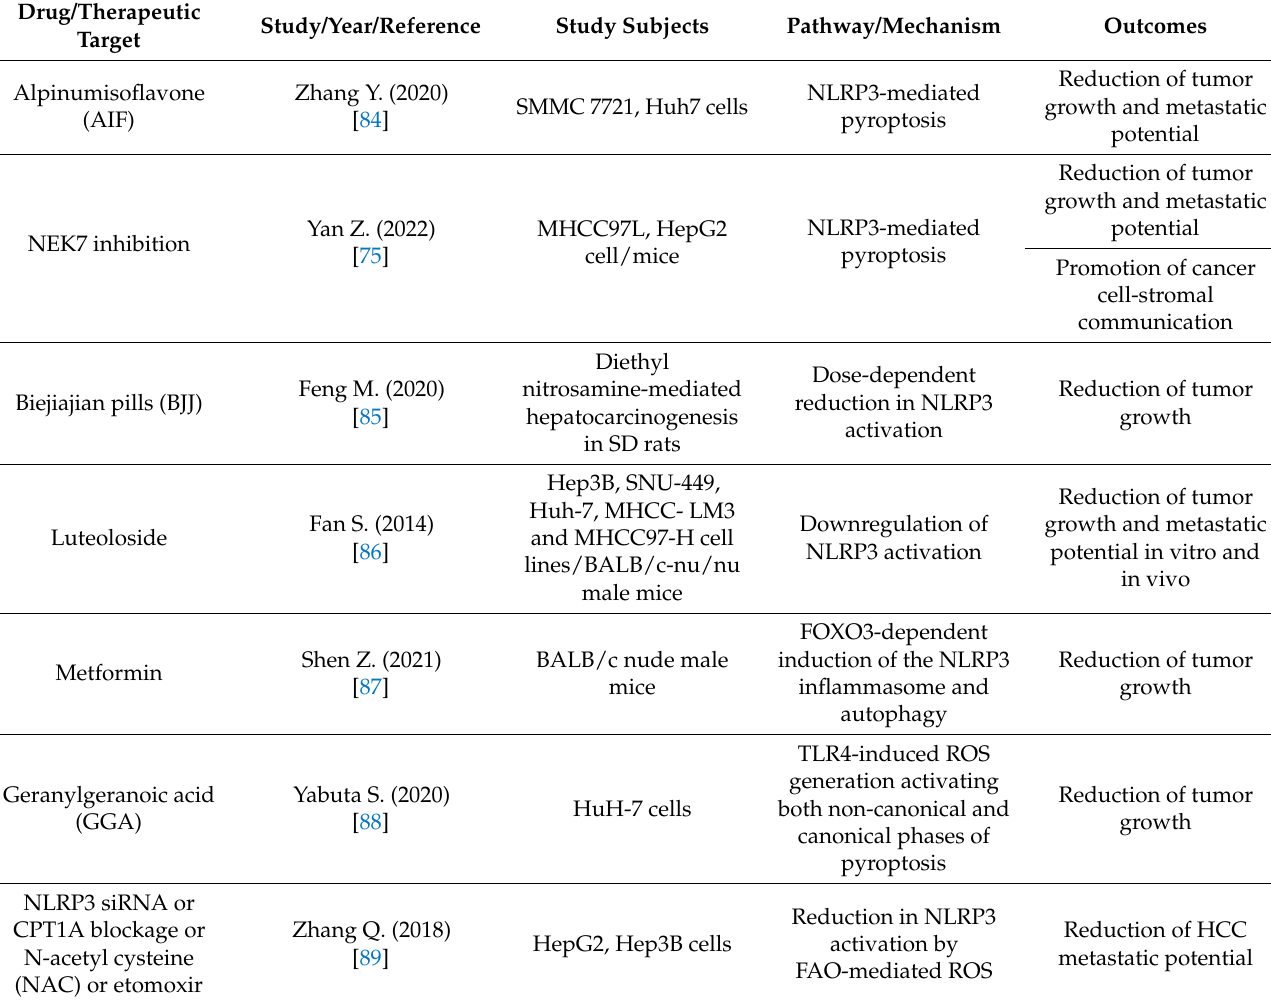
Table 2. A brief summary of the preclinical data with respect to NLRP3